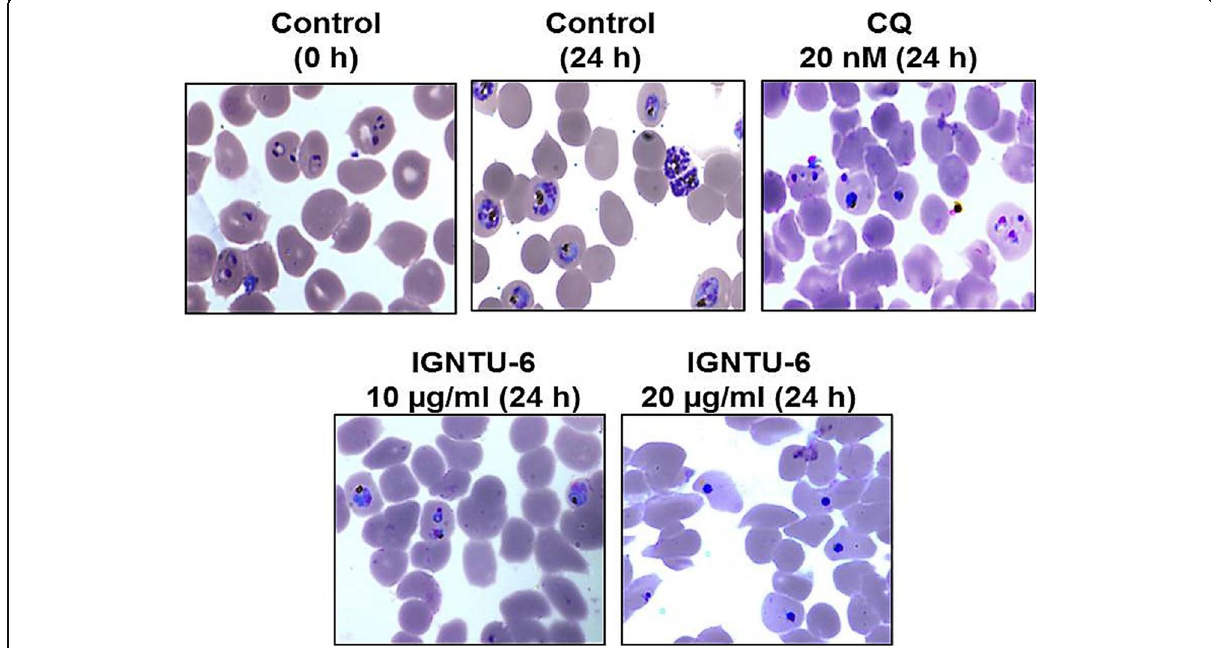
Fig. 1 Microscopic examination of Giemsa-stained Plasmodium falciparum (PF-3D7) strain maintained in human RBCs. Slides were prepared at different time-points before and after compound/plant extract treatment. Compound/plant extract treatment is given at ring-stage. Chloroquine (CQ) is used as a positive control